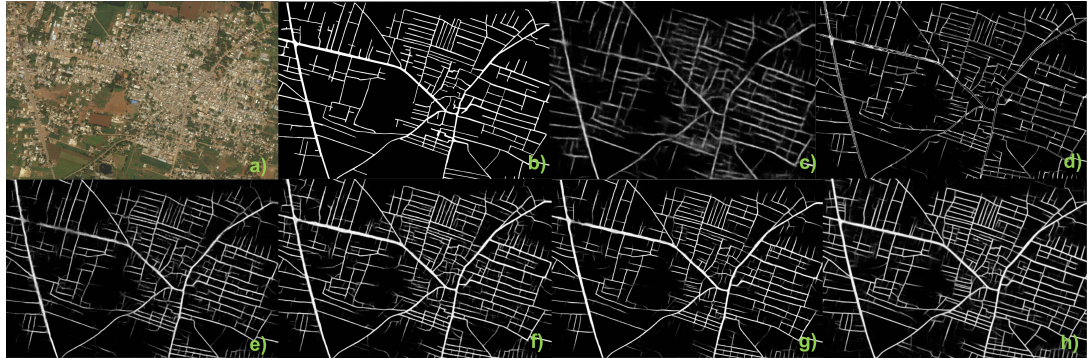
Figure 6. Comparison of NN Models. An example ( a ) satellite image and ( b ) ground truth; and road predictions using ( c ) VGG; ( d ) U-Net; ( e ) ResNet50; ( f ) ResNet101; ( g ) SegNet; and ( h )